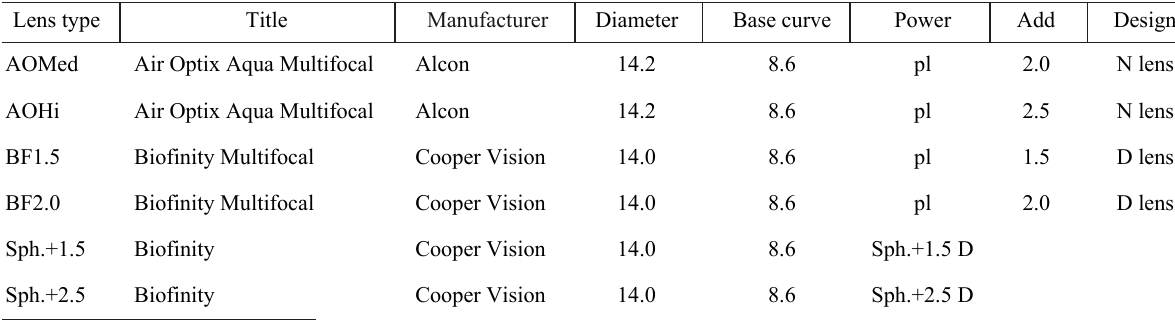
Table 1. The list of the used contact lenses with different Add design, power and